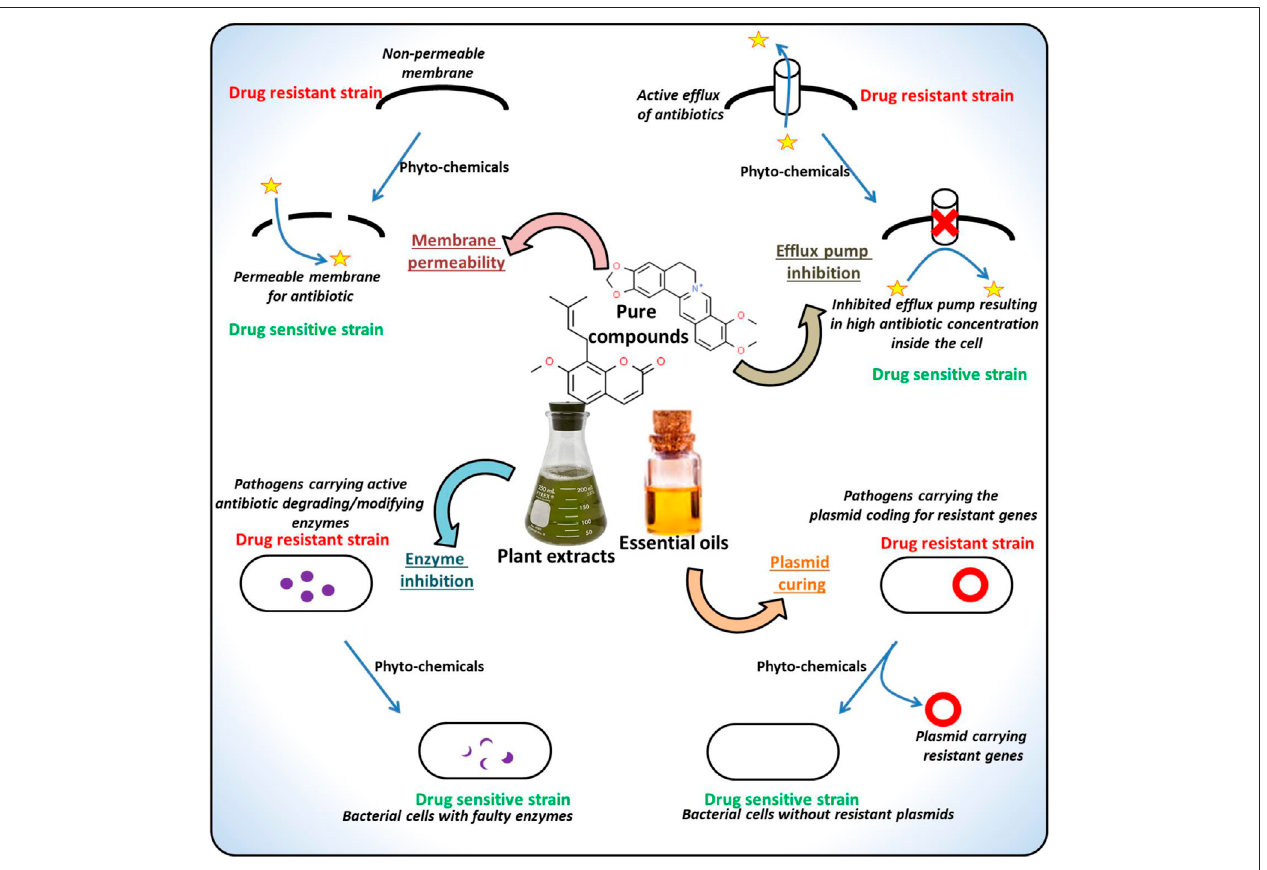
FIGURE 3 | Major mechanisms underlying microbial drug-resistance targeted by the phytochemicals.